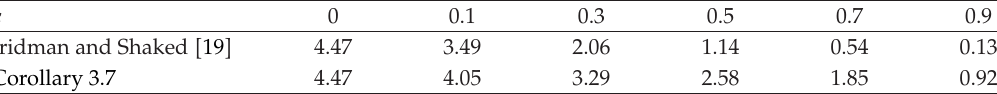
Table 3: Allowable upper bounds of τ 2 for di ff erent c